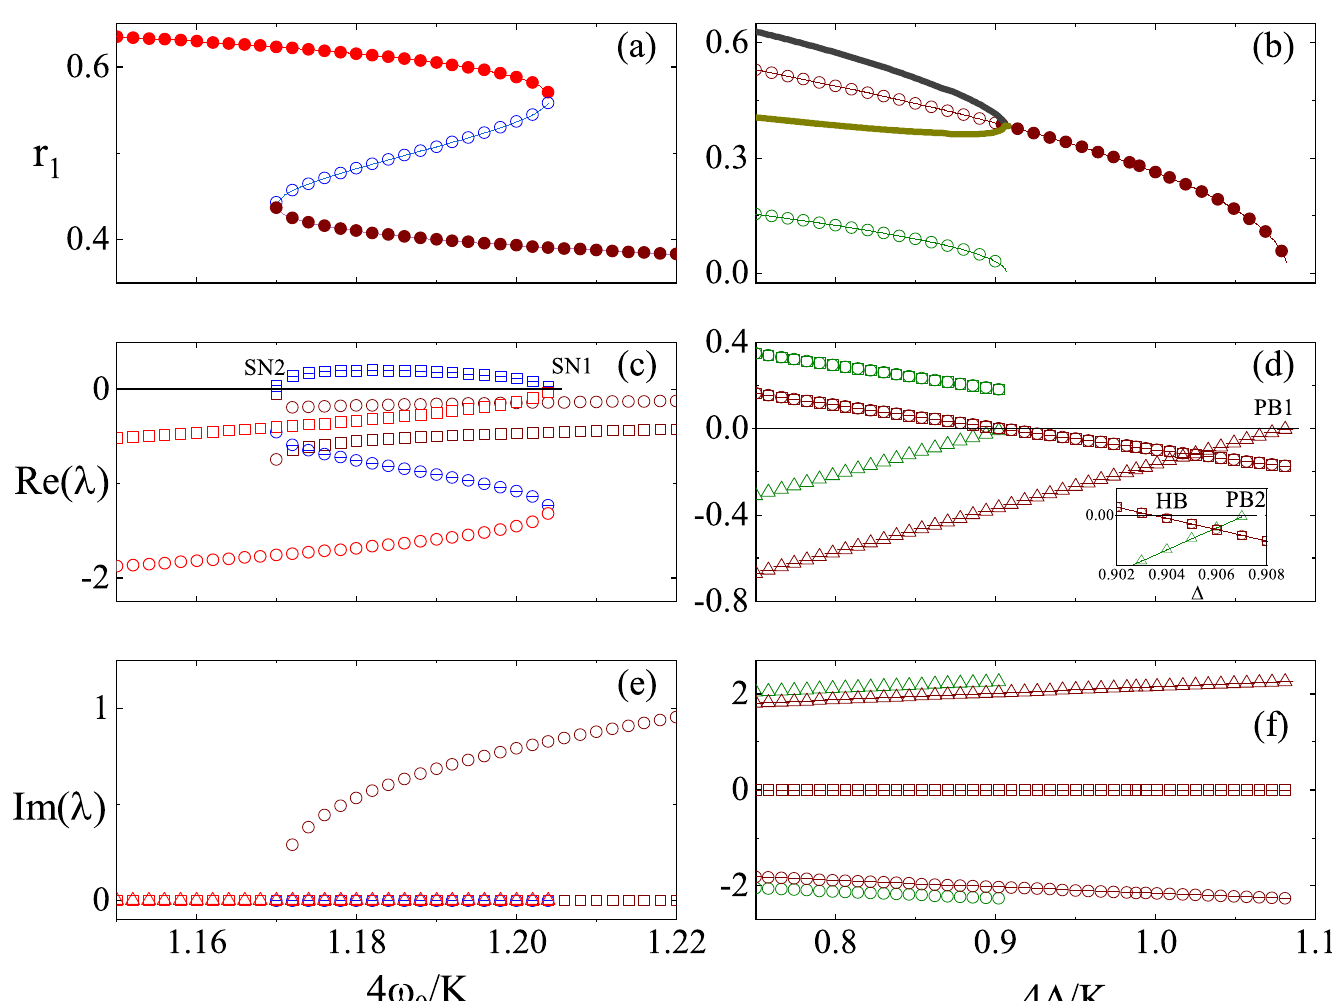
Fig 2. (Color online) Bifurcation diagrams of r 1 and λ against ω 0 = 4 ω 0 / K at Δ 0 = 4 Δ / K = 0.95 (left column) and against Δ 0 at ω 0 = 1.5 (right column). Solid (open) data points represent stable (unstable) states. In (a), red, blue, and wine lines are for partial synchronous states FP ð 2 Þ green lines are for partial synchronous states FP ð 3 Þ from (c) to (f), squares, circles, and triangles denote the real and imaginary parts of eigenvalues λ 1 , λ 2 , and λ 3 , respectively. The inset of (d) shows that HB occurs at a lower Δ 0 than PB2. Note that the incoherent state changes its stability across the pitchfork bifurcation (PB1).